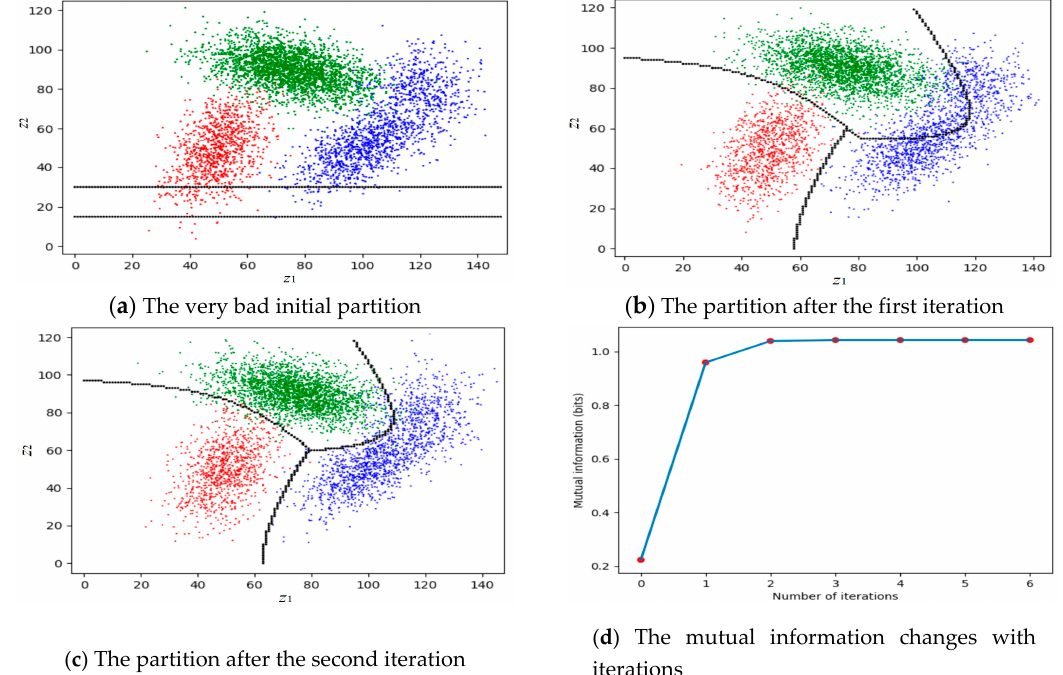
Figure 12. MMI classification with a very bad initial partition.